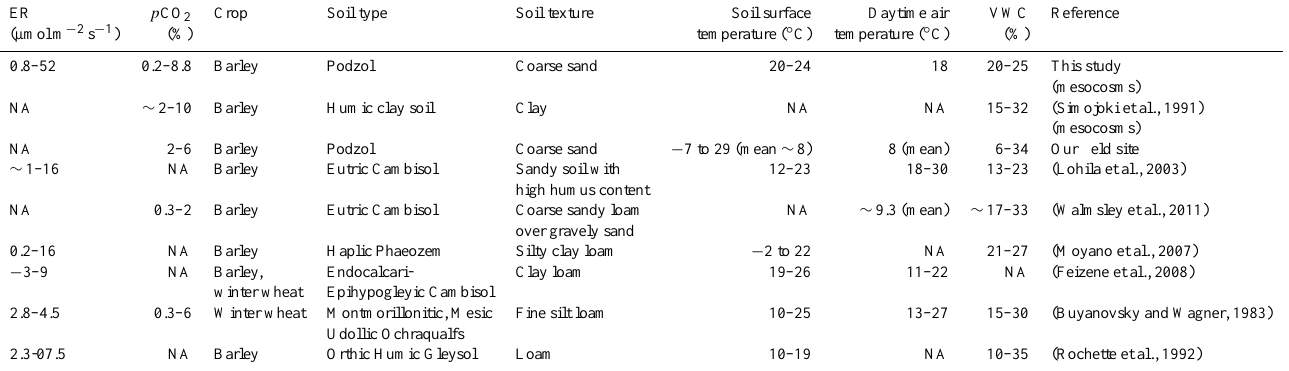
Table 3. Ranges of ecosystem respiration (ER) and soil partial pressure of CO 2 ( p CO 2 ) during growth in barley mesocosms as compared to other studies (two in mesocosms, seven in the field). NA represents not available, VWC represents volumetric water content. ER p CO 2